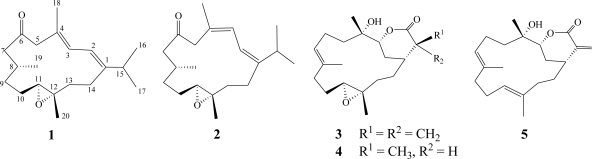
Structures of 1–5.